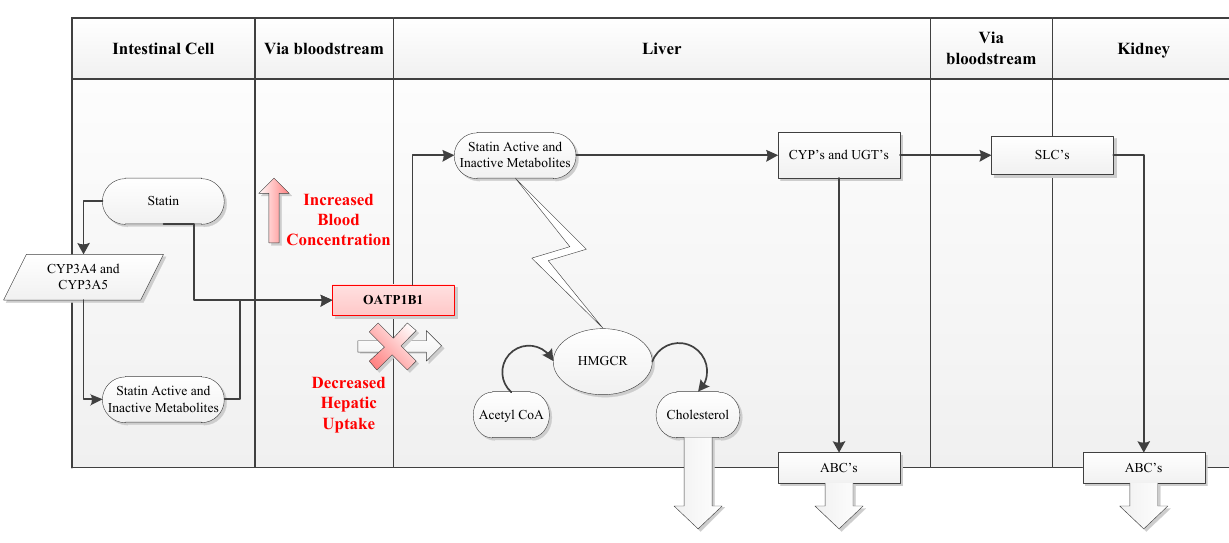
Figure 2. Statin Uptake Pathway. ( a ) SLCO1B1 encodes the OATP1B1 influx transporter. ( b ) OATP1B1 transport is particularly important for hepatic accessibility of statins. The transporter contributes to liver uptake of statins including first pass clearance from the portal circulation so that decreased transport results in increases systemic (including muscle) exposure to statin. ( c ) HMGCR = 3-hydroxy-3-methyl-glutaryl-CoA reductase, CYP = cytochrome P450 isoenzymes, UGT = UDP-glucuronyl transferase class